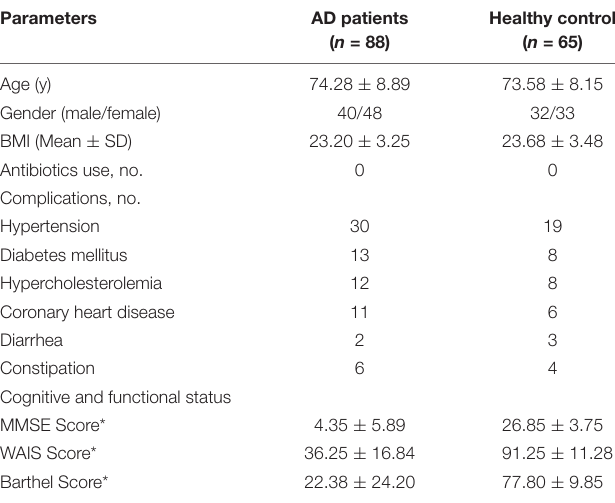
TABLE 1 | The fundamental information of